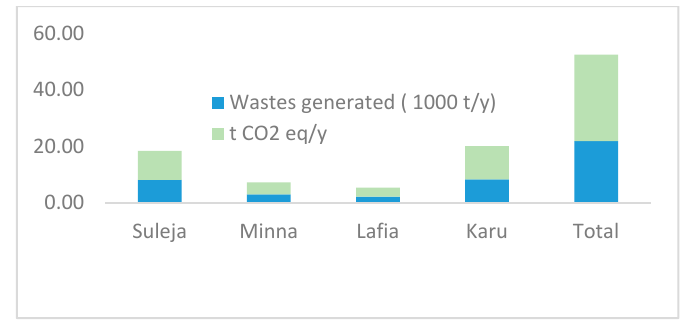
Figure 5. Annual reduction of GHGs (t CO 2 eq) using anaerobic digester (AD).